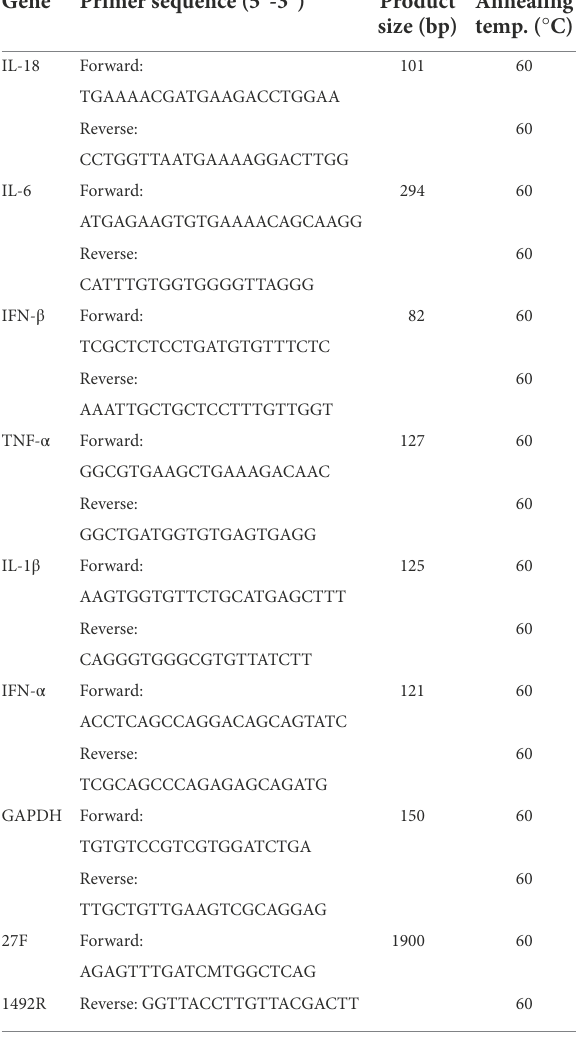
TABLE 1 Primer sequences and annealing temperatures for polymerase chain reactions. Gene Primer sequence